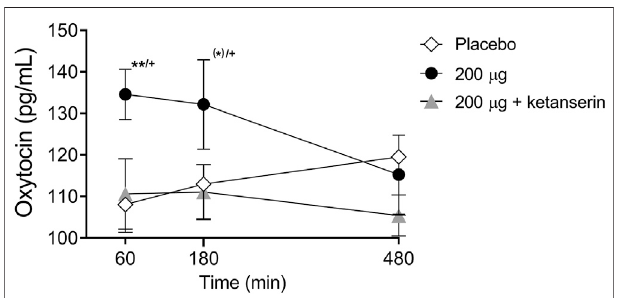
FIGURE 3 | Effects of LSD on circulating oxytocin. LSD alone signi fi cantly increased plasma oxytocin concentrations 60 min after administration compared with placebo. LSD did not increase oxytocin levels after ketanserin pretreatmentcompared with placebo pretreatment. The data are expressed as the mean ± SEM in 16 subjects ( * ) p < 0.1, ** p < 0.01, compared with placebo; + p < 0.05, compared with LSD + ketanserin.